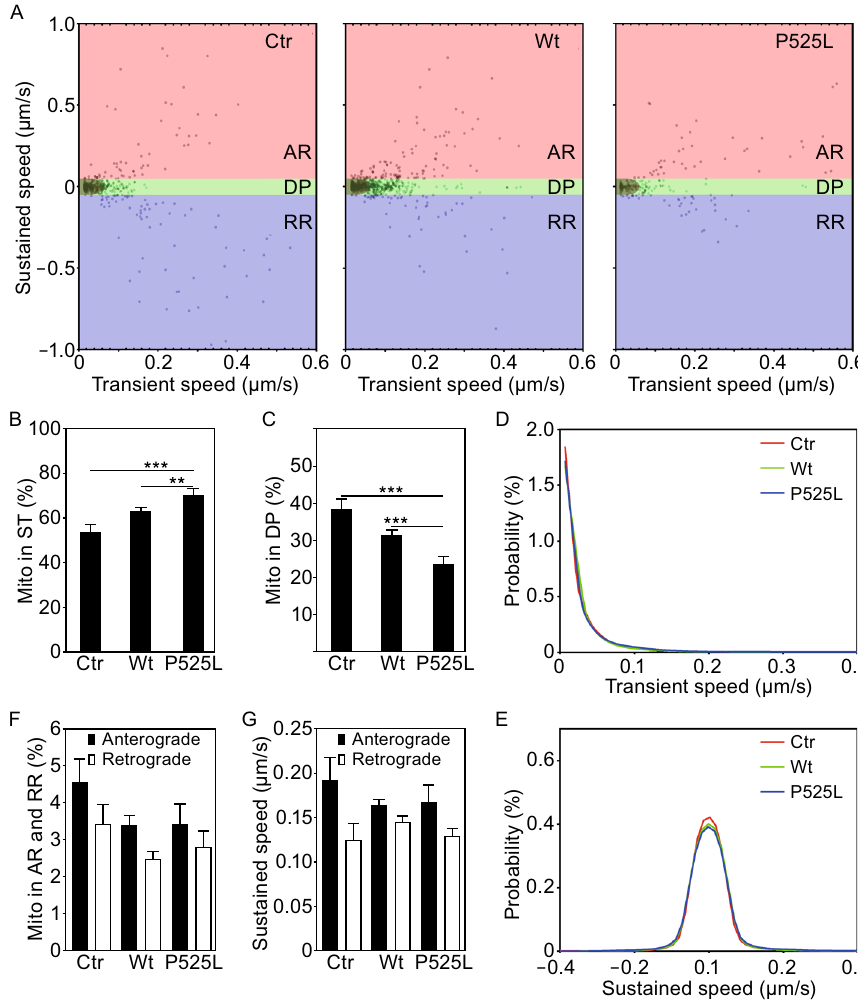
Figure 4. Expression of FUS protein decreases axonal mitochondrial transport in cultured mammalian neurons. (A) A 2-D parameter space was created by calculating sustained and transient component of speed of mitochondrial movement in each group of neurons expressing the vector control (Ctr), wild-type FUS (Wt) or P252L-mutant FUS (P525L) proteins. (B and C) A signi fi cant increase in the percentage of mitochondria in stationary (ST) and a signi fi cant decrease in the percentage of mitochondria in dynamic pause (DP) in axons of neurons expressing either Wt-FUS or P525L-mutant FUS as compared with the control group. (D) The regression results of alternate component of transient speed. The distribution of transient speed in different group was similar. (E) The distribution comparison of sustained speed. (F) Percentage of mitochondria in running state (AR or RR) was determined among different groups of cultured neurons. (G) Sustained speed of running mitochondria was determined in different groups of cultured neurons. At least 100 axonal bundles from at least 4 chambers were analyzed for each group. Data represent at least 3 independent experiments [one-way ANOVA, (* P < 0.05; ** P < 0.01; *** P